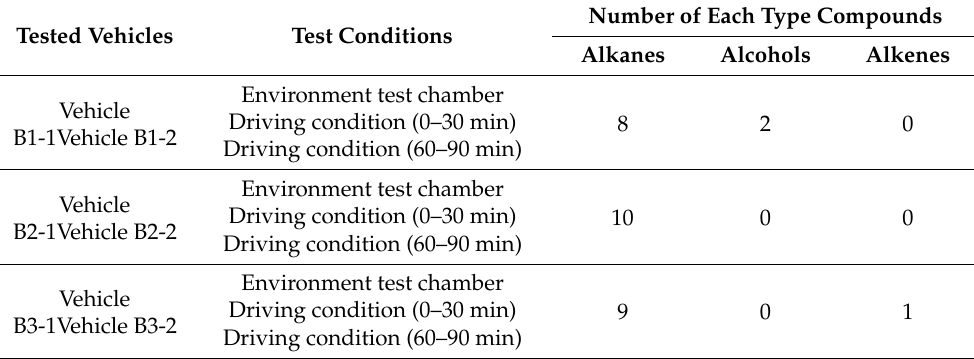
Table 4. Types of the top 10 VOCs identified in interior air samples of Brand B. Tested Vehicles